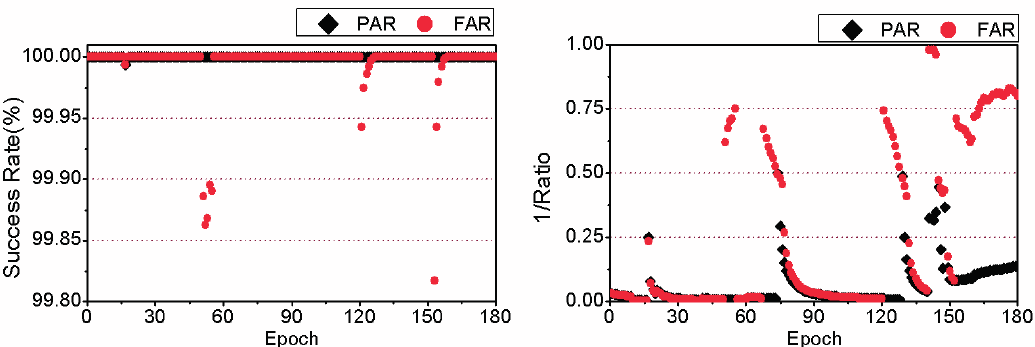
Figure 10. Success rate ( Left ) and reciprocal of ratio test value ( Right ) of kinematic PPP with PAR and FAR for the observations of the 4th session of the MOBS station on 25 January